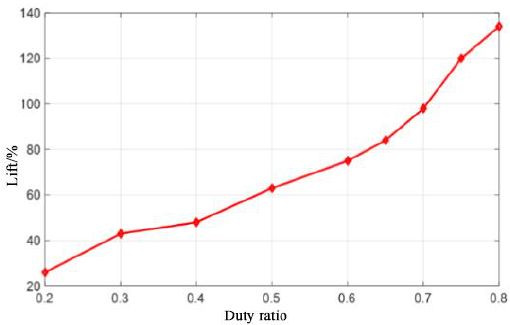
Figure 16. Voltage gain improvement curve.